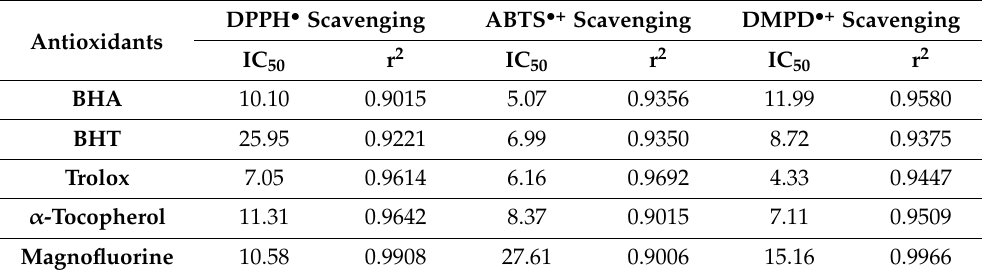
Table 2. IC 50 ( µ g/mL) values for DPPH • , DMPD • + , and ABTS • + scavenging of Magnofluorine and standard antioxidants.